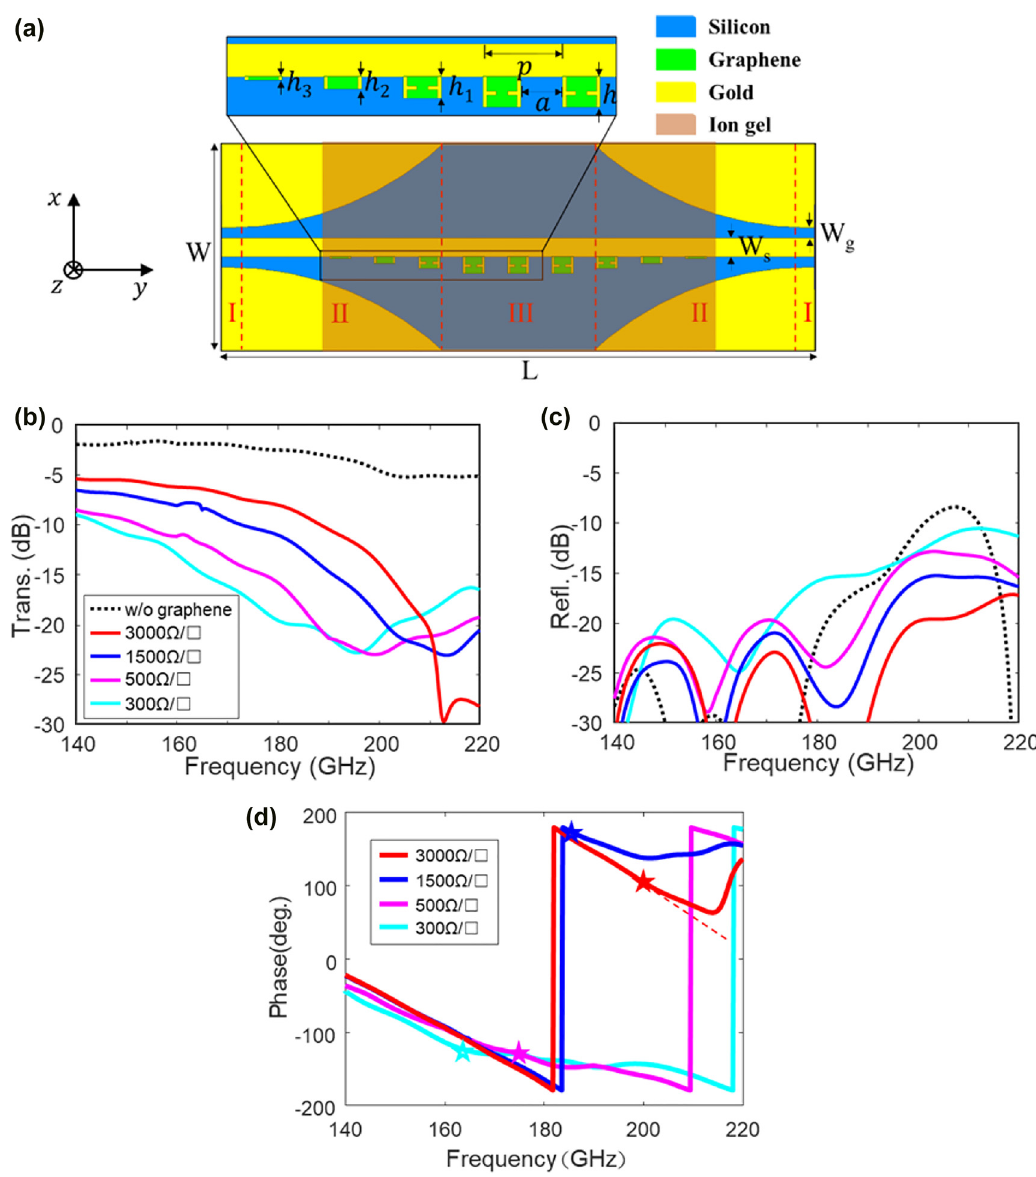
Figure 2: Simulation of a metal–graphene hybrid structure with CPW feeding. = 58 μ m, h = 34 μ m, h = 10 μ m, W = 1.5 mm, L = 2.8 mm, W (a) 3-D model ( h 1 2 3 reflectance, (d) transmittance phase at various sheet resistances. The star marker depicts the phase deviation point with respect to linear